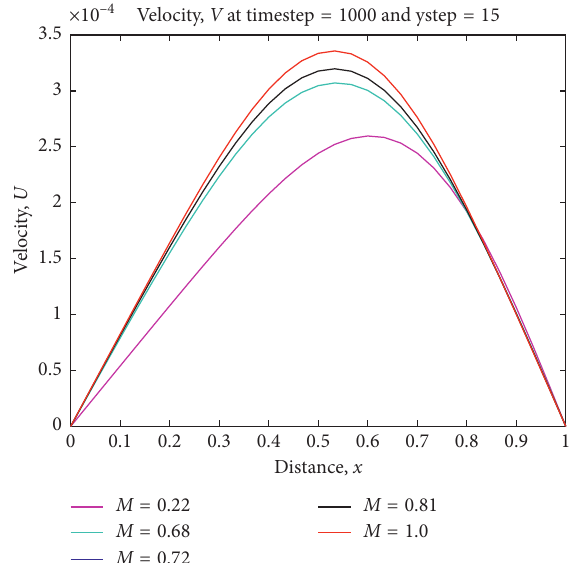
Figure 4: Graph of effects of the Schmidt number on primary velocity profile u .